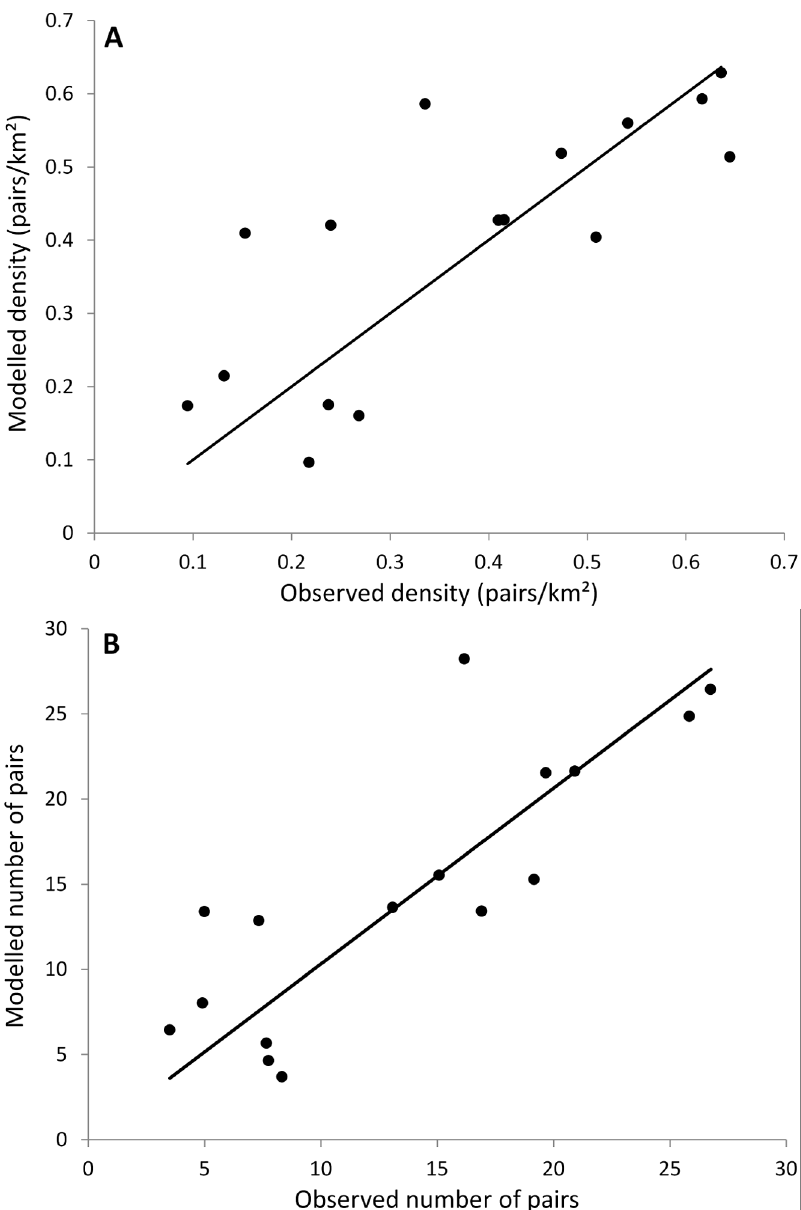
Figure 2. The relationship between the modelled mean densities (A) and pairs (B) of skylarks in the 16 study areas in Bjerringbro derived from the ALMaSS skylark model and the mean observed densities (A) and pairs (B) obtained from surveys carried out 1998 to 2000. * is Farm 14 referred to in the text.